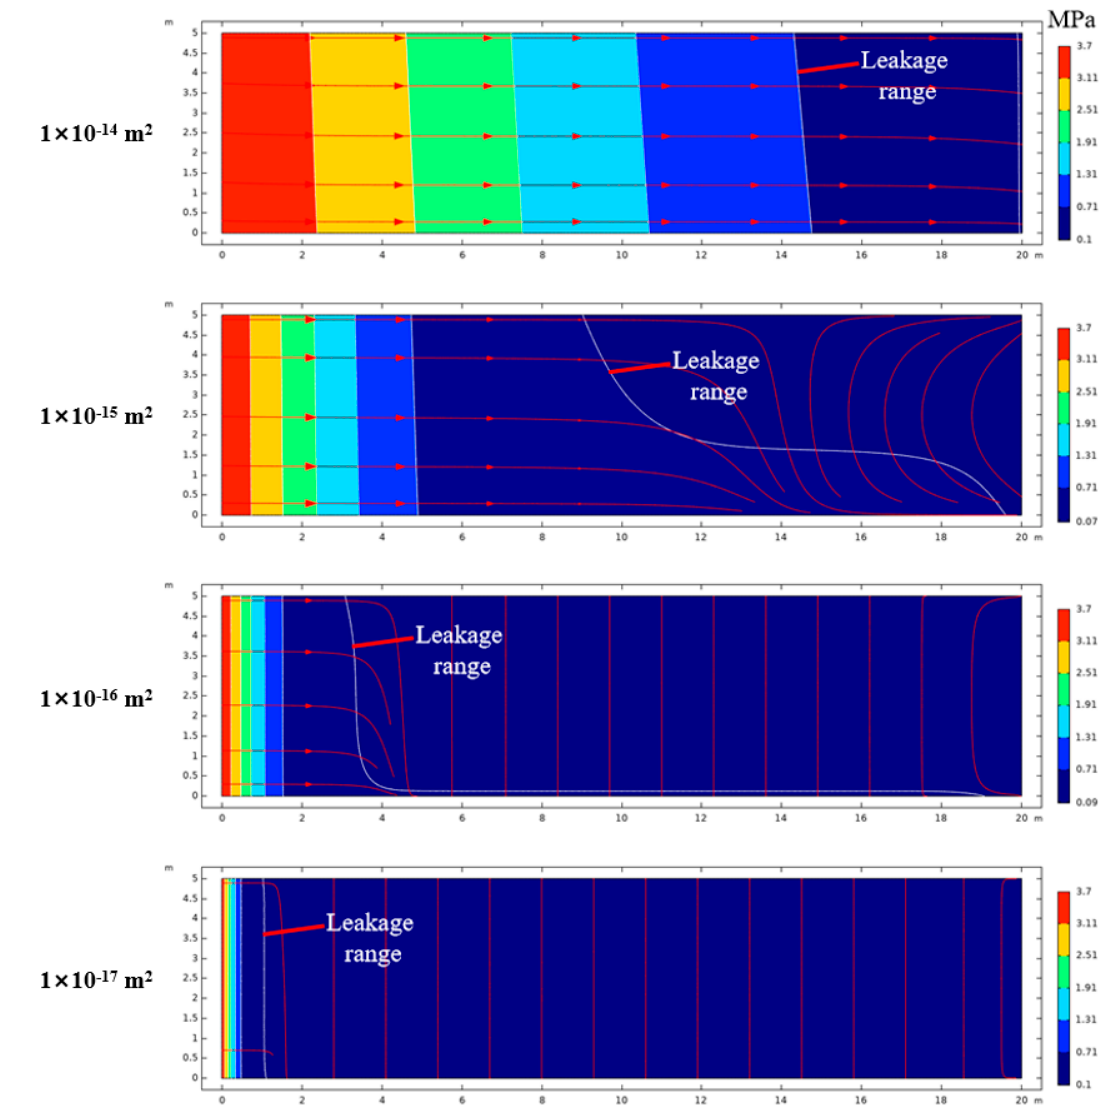
Figure 10. Leakage range and streamlining the distribution of coal pillar dam with different permeability.